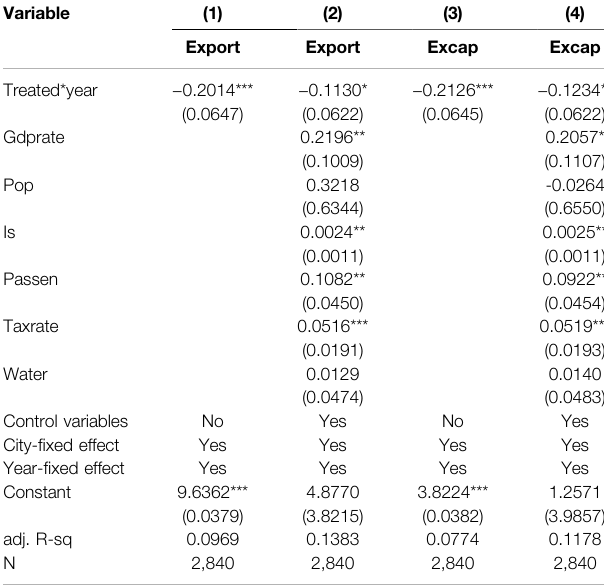
TABLE 2 | Impact of EID on local exports: DID